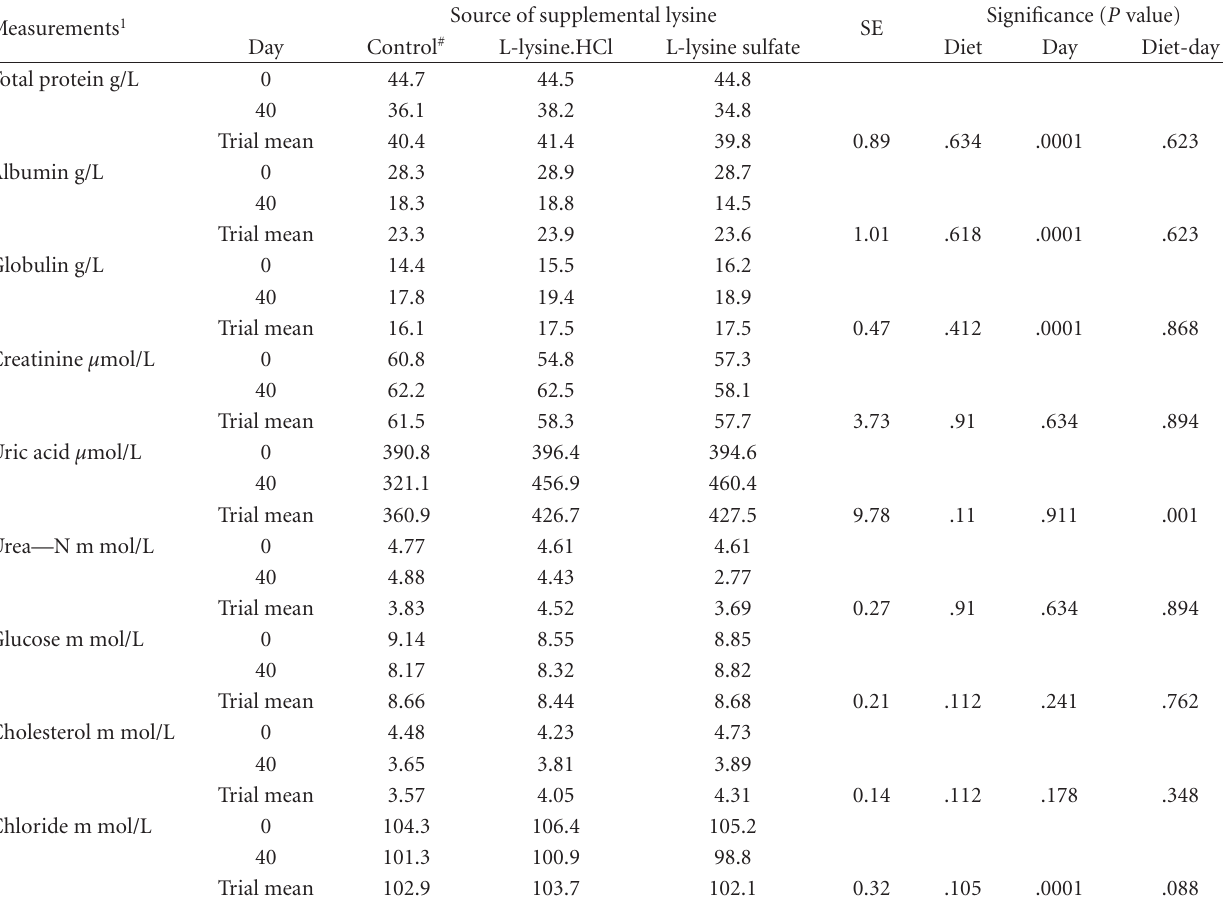
Table 4: Serum metabolites in broiler chickens fed diets supplemented with L-lysine.HCl and L-lysine